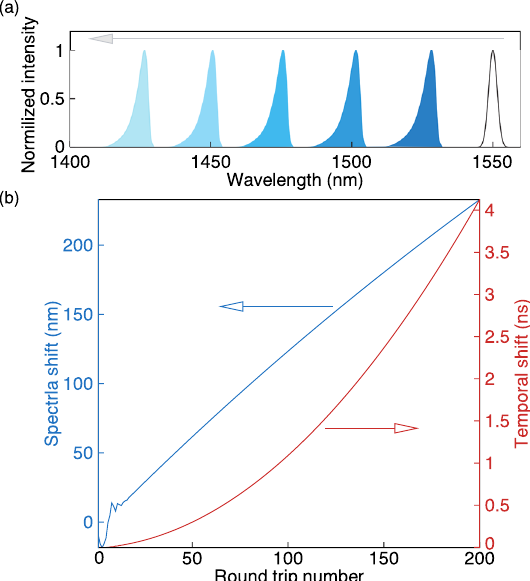
Figure 2. ( a ) Shape of the intracavity spectrum after SOA depicted at every 20th round trip of the cavity. Black line shows the initial spectrum. ( b ) Evolution of peak power position and central wavelength of the output pulse during the first 200 round trips. Here the laser cavity includes 5 meters of DCF and 35 meters of SMF. No spectral filter is used.